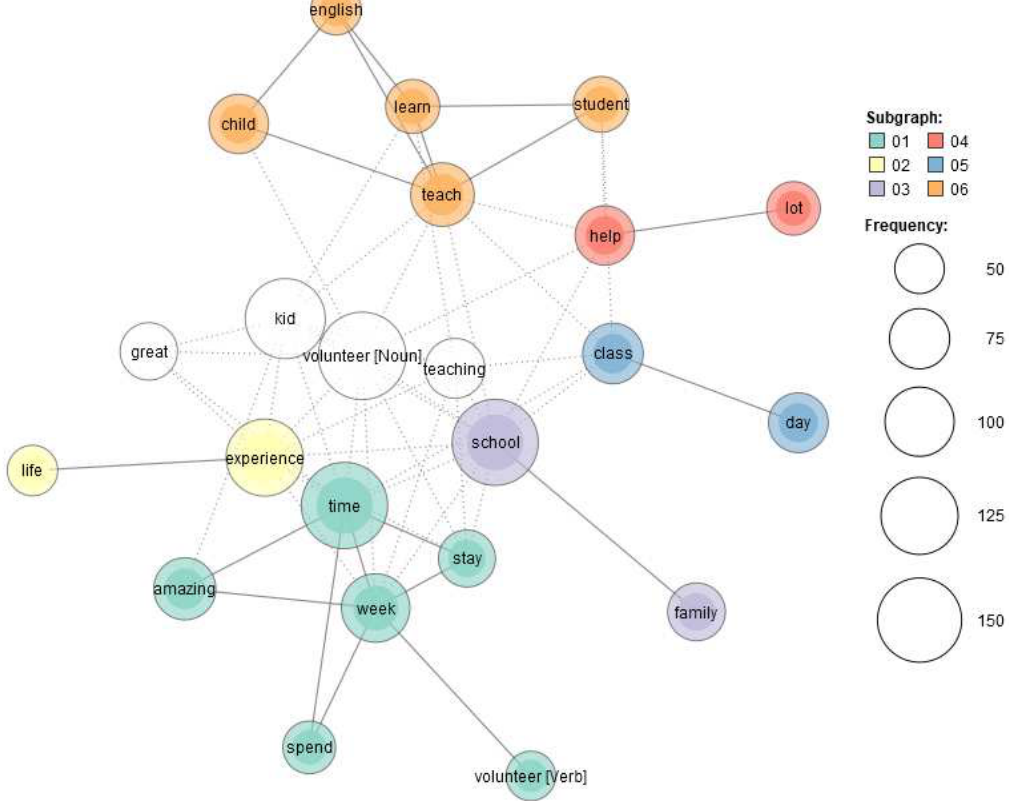
Figure 3a. Co-occurrence network of words (India data